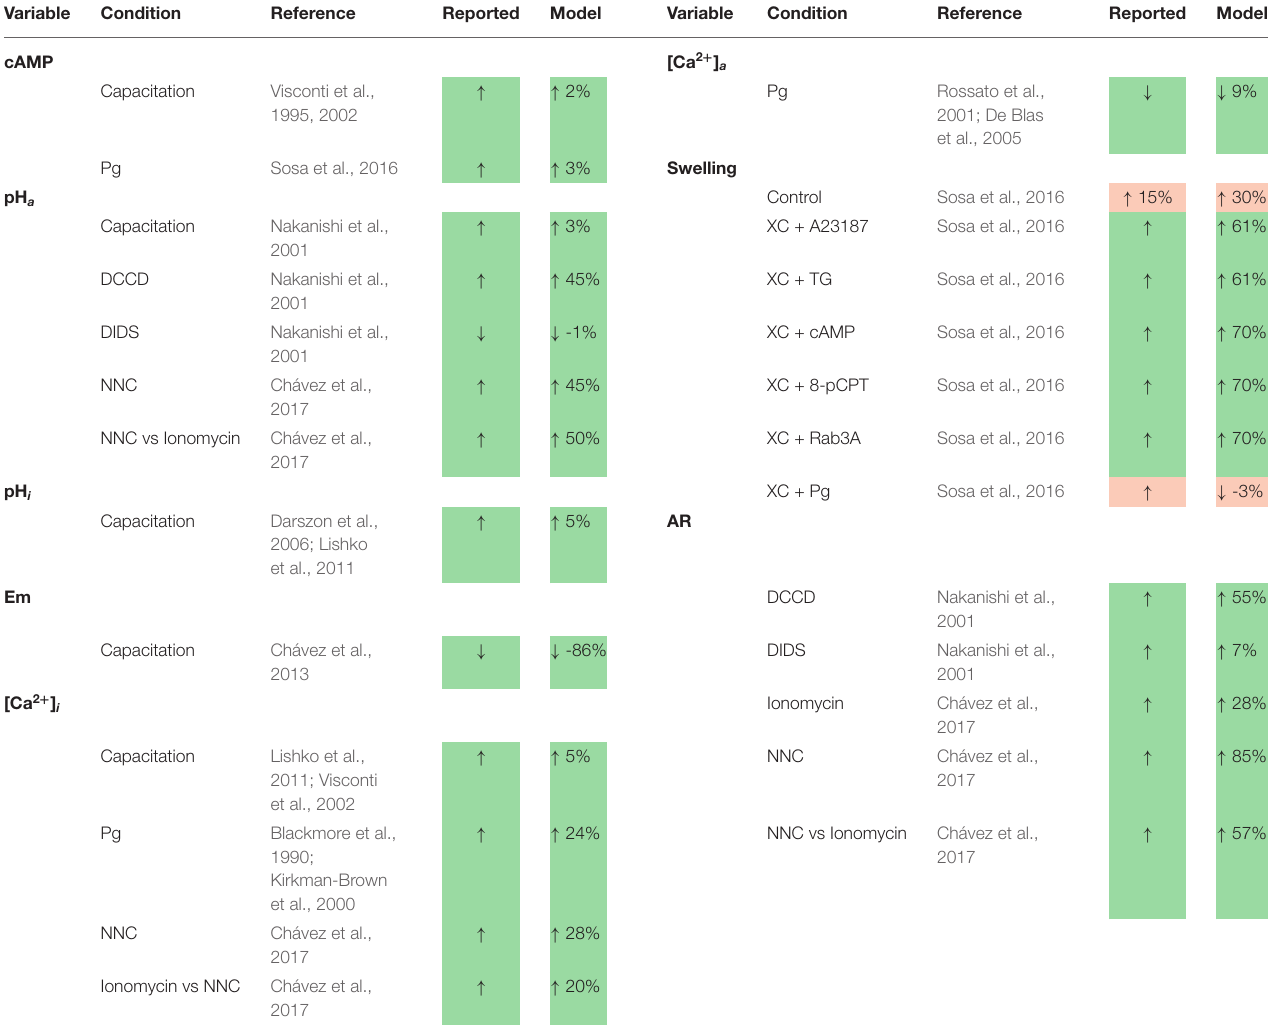
TABLE 2 | Experimental observations compared with the behavior of the acrosome reaction (AR) discrete network.